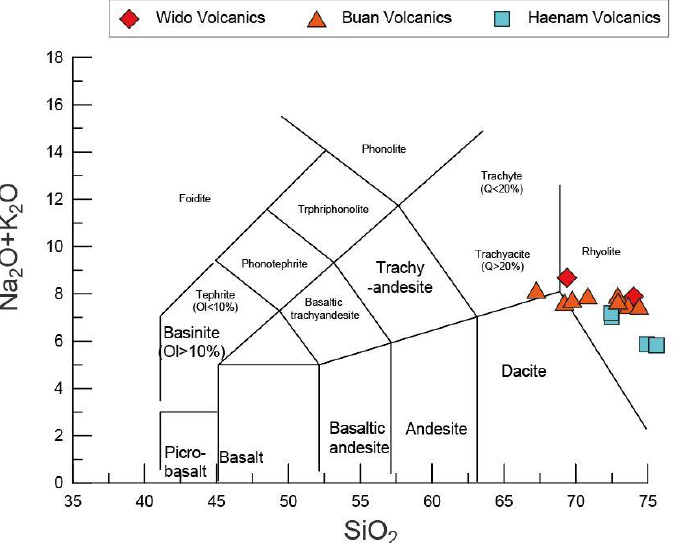
Figure 7. Diagrams of SiO 2 wt % versus Na 2 O + K 2 O wt % for the Cretaceous volcanic rocks from the southwestern Korean Peninsula.